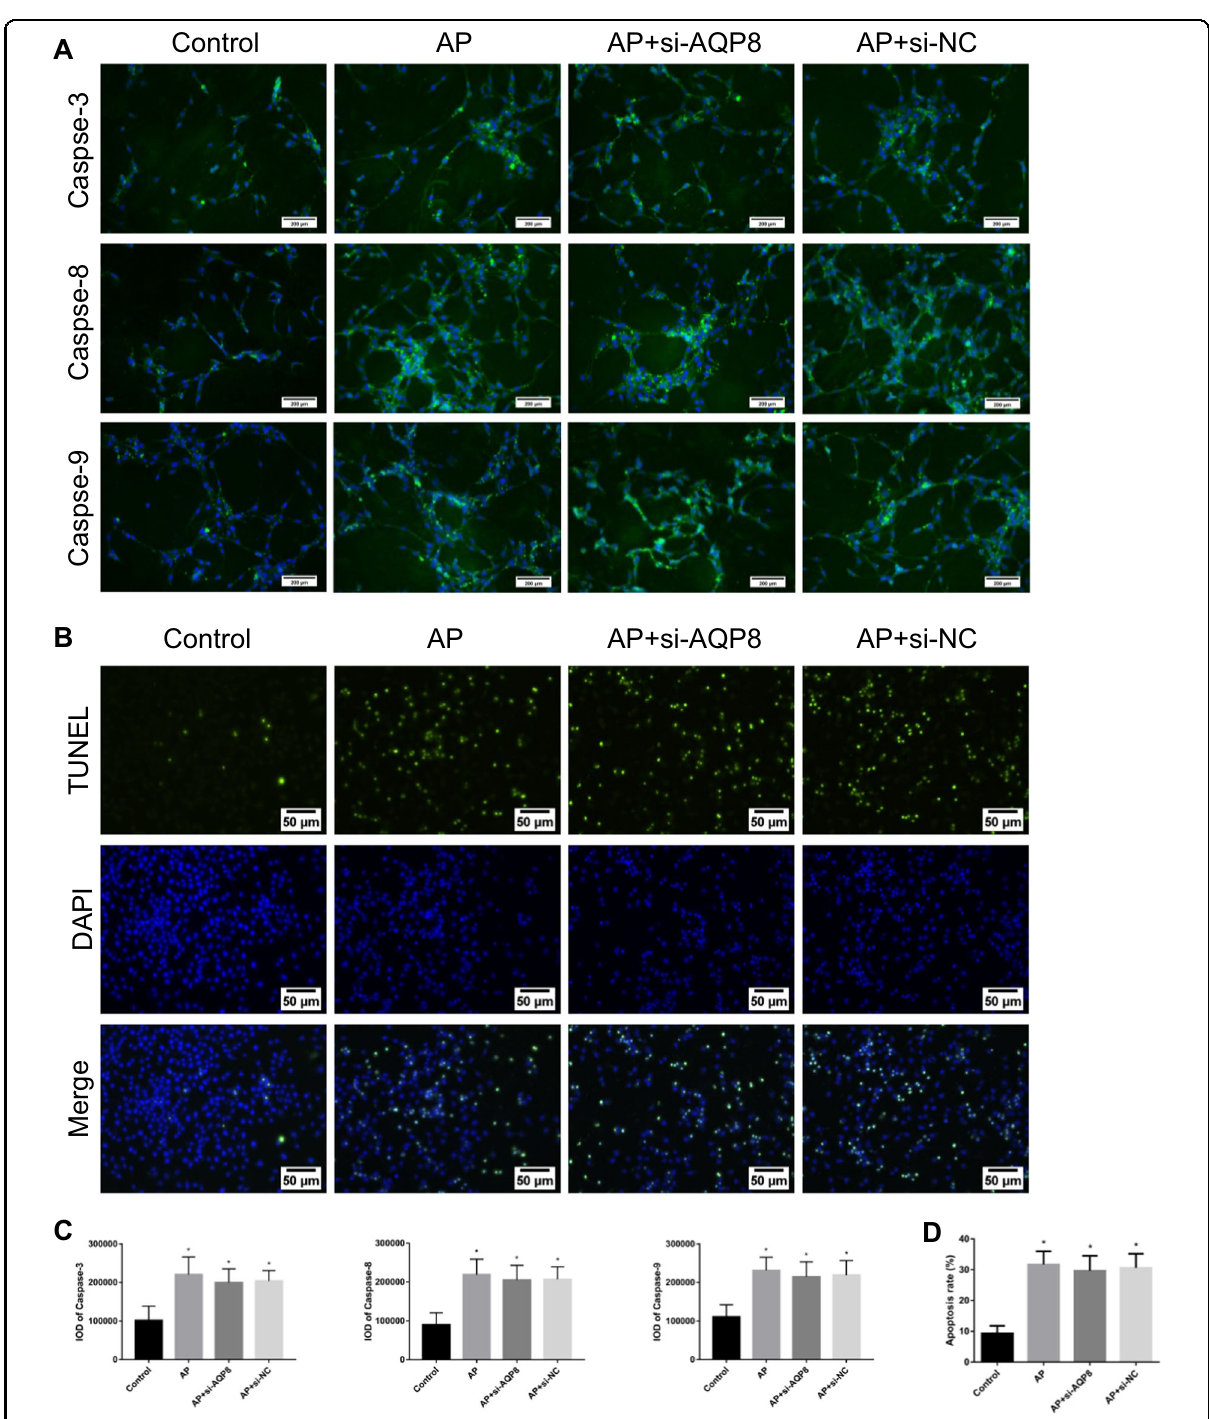
Fig. 7 Inhibition of AQP8 during AP did not affect apoptosis in vitro. a Immuno fl uorescence staining revealed the expression of Caspase-3, Caspase-8, and Caspase-9 in the cytoplasm of AR42J cells from the Control, AP, AP + si-AQP8 and AP + si-NC groups. The green signal represents Caspase-3, Caspase-8, and Caspase-9 staining. The blue signal represents nuclear DNA staining by DAPI; bar: 200 μ m. b A TUNEL assay was used to measure apoptosis in AR42J cells and ( d ) determine the apoptosis index in the AR42J cells described in Fig. 7b. c The histograms show the IOD of Caspase-3, Caspase-8, and Caspase-9 in the AR42J cells described in Fig. 7a. The data are the means ± S.Ds. ( n = 3). * P < 0.05 versus control, ^ P < 0.05 versus